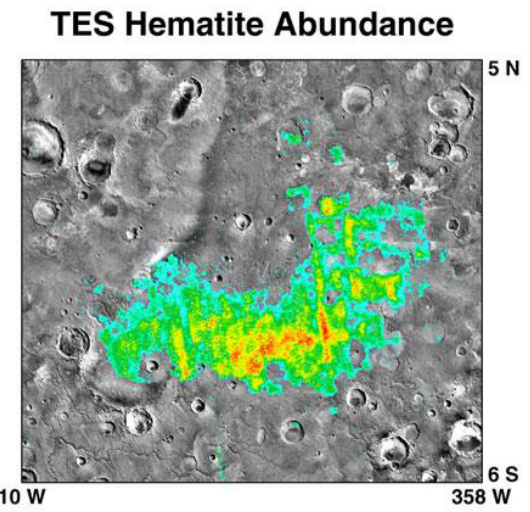
Figure 16. Map showing the distribution of hematite in Sinus Meridiani. This data was used to target the landing of the Opportunity rover that found definite evidence of past water.